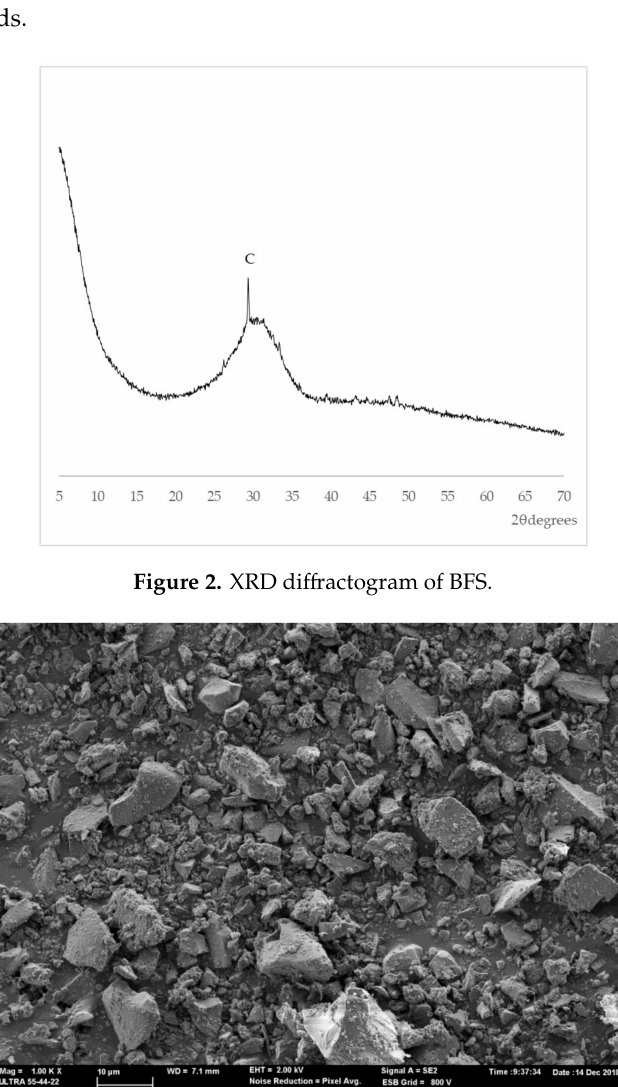
Figure 3. FESEM micrograph of the milled BFS at 1000 ×